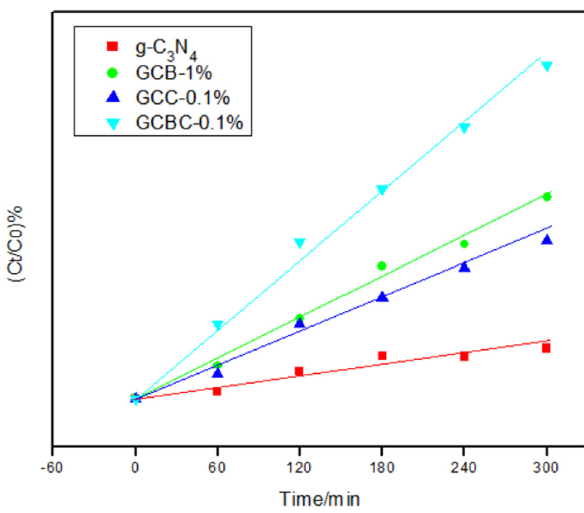
Figure 4: First order kinetics of SMZ degradation in various samples.